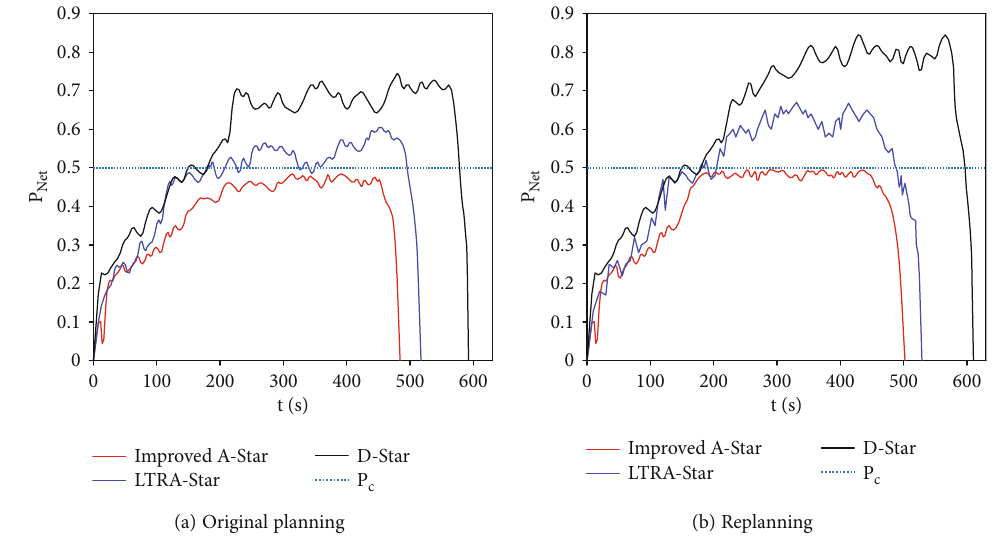
Figure 13: The detection probability of netted radar in the third threat scenario. Table 7: The statistical result of fl ight in the third scenario.